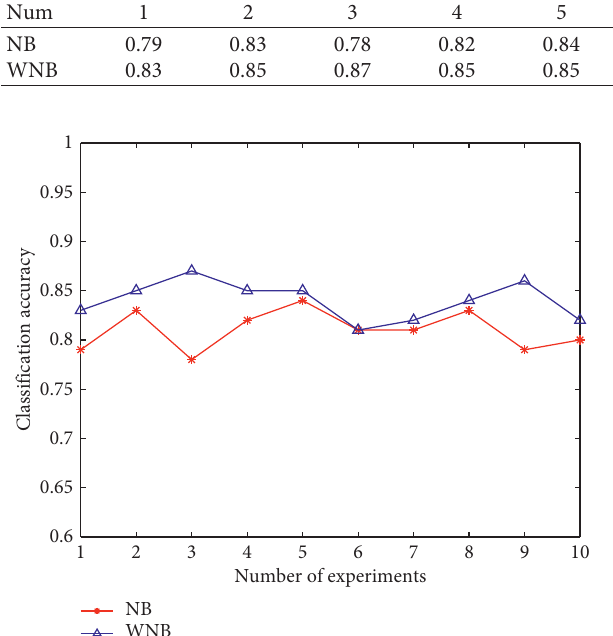
Figure 4: Comparison of classification accuracy between NB and WNB algorithm.